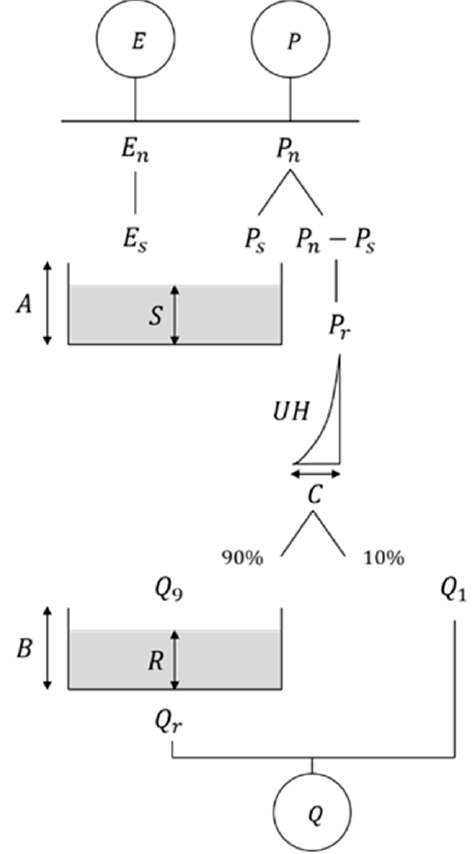
Figure 3. The framework of GR3 model .